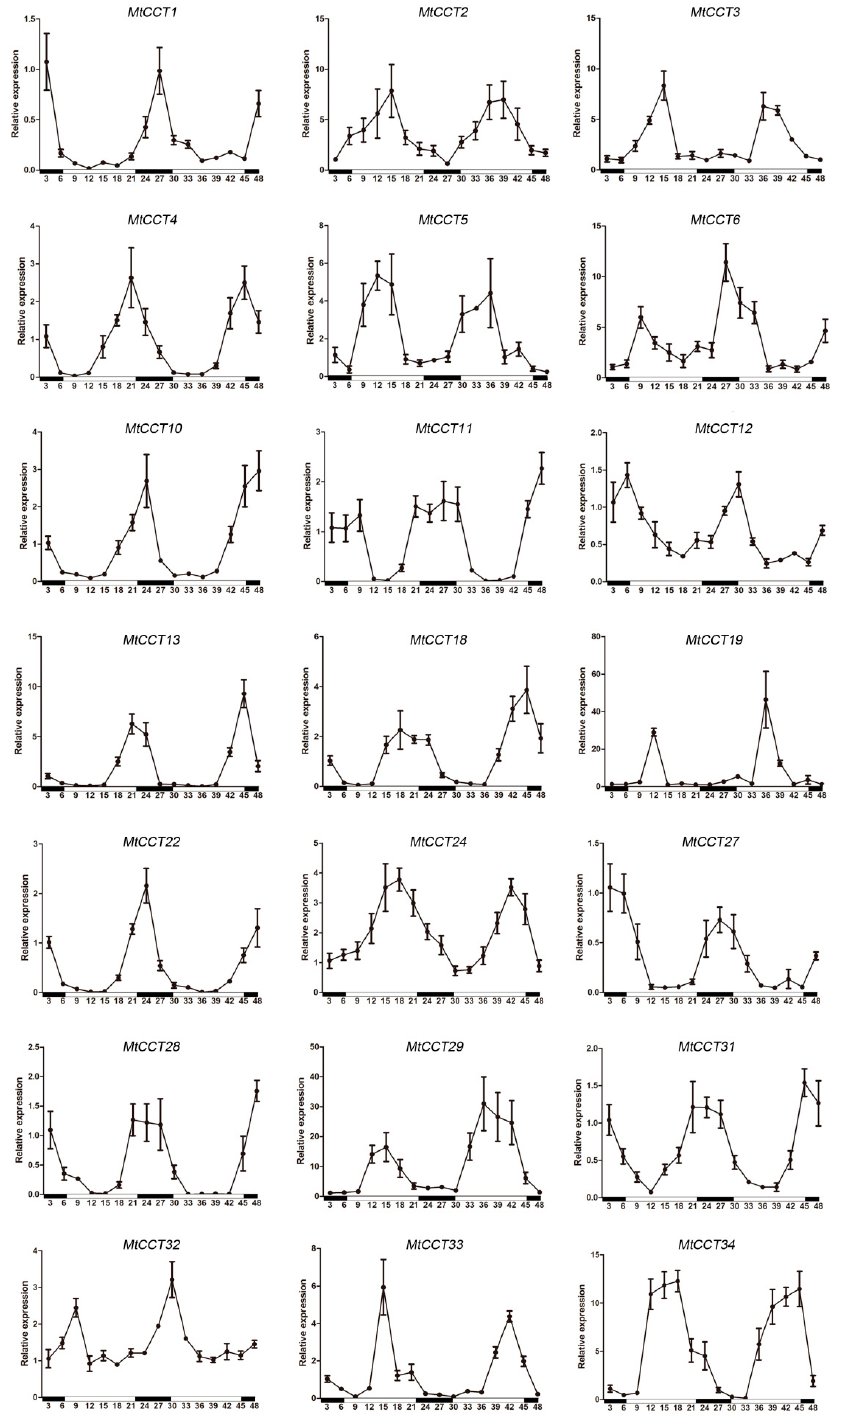
Figure 5. Diurnal expression patterns of MtCCT genes’ response to light circle. The white and black bars represent the light and dark periods, respectively. Expression levels are normalized to MtACTIN and error bars indicate standard deviation among three biological replicates.